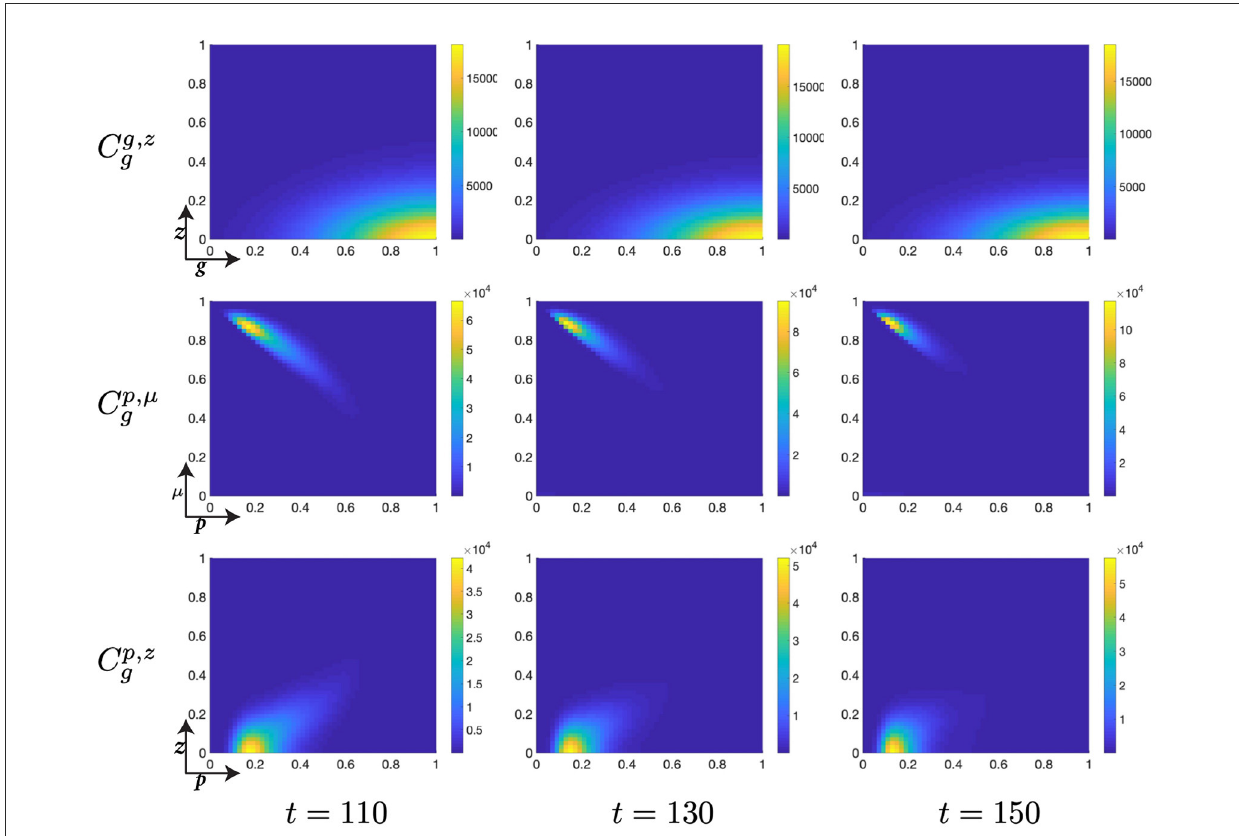
FIGURE14 Structured G-phase cell population given in: the G-cyclin-DNA-damage plane ( g , z ); the p53-mdm2 plane ( p , µ ); and the p53-DNA-damage plane, with a reduced mutational repair rate ( χ z